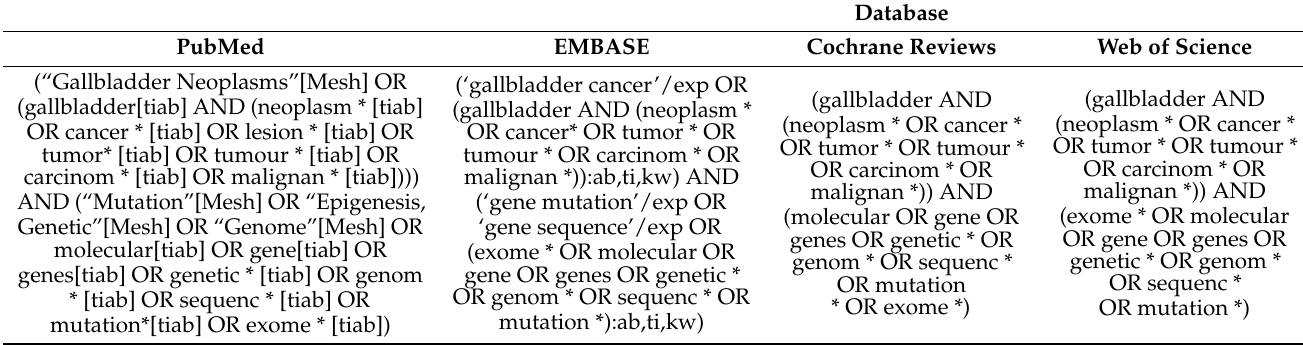
Table A1. Keywords and subject headings used in the literature